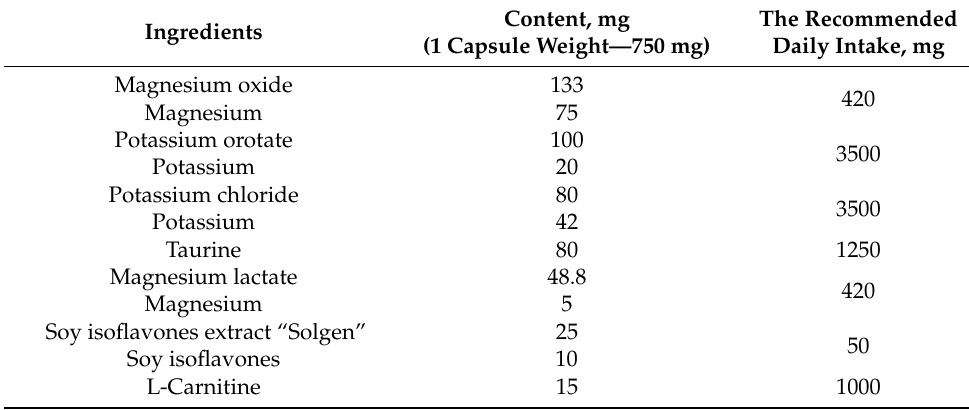
Table 1. The chemical composition.